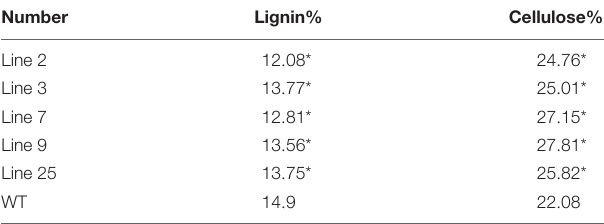
TABLE 1 | Determination of lignin and